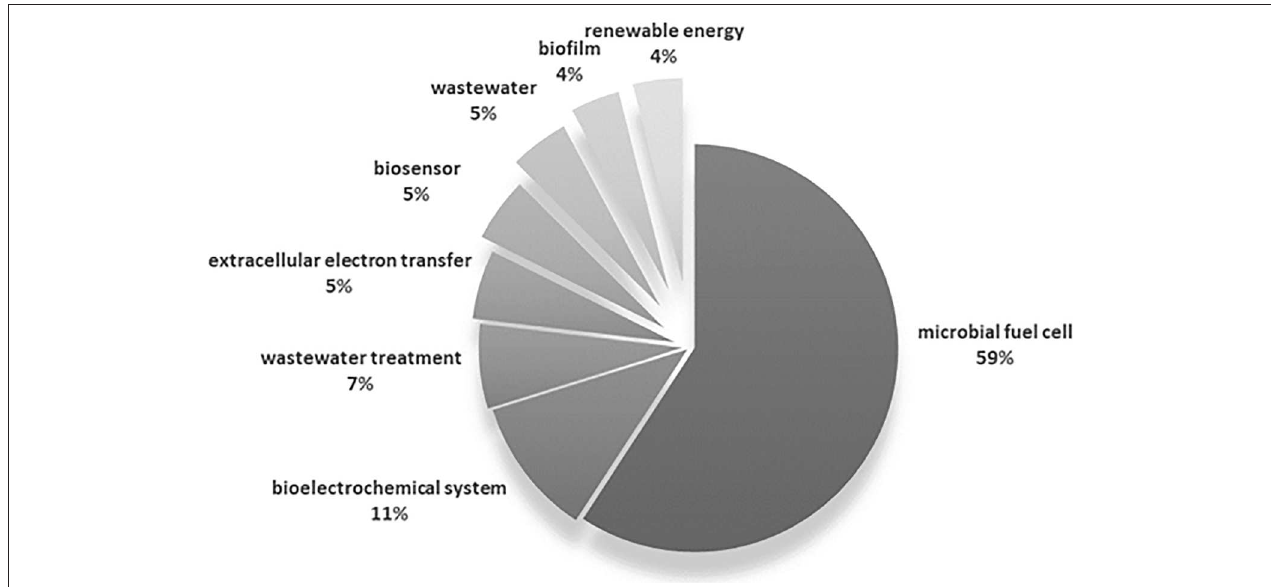
FIGURE 6 | Summary of the occurrence of the most common author keywords derived from works citing the work of Potter (1911).